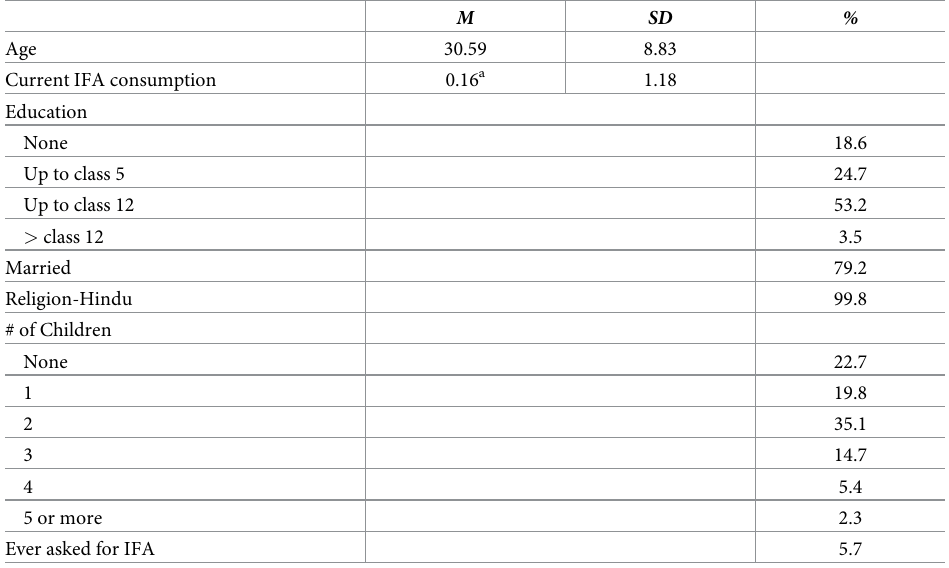
Table 1. Demographic profile of